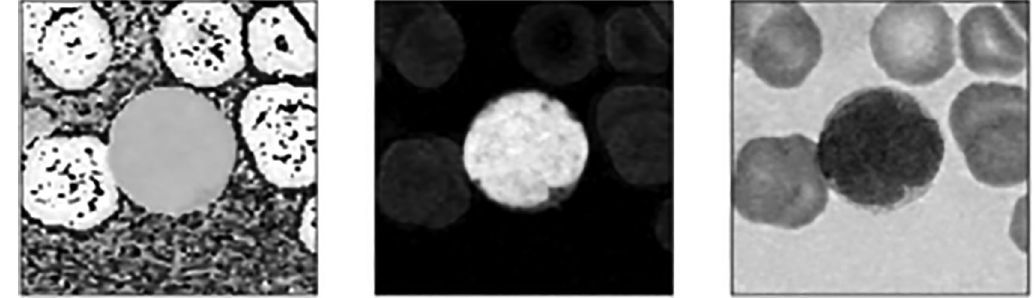
Figure 3. H, S and V channels.